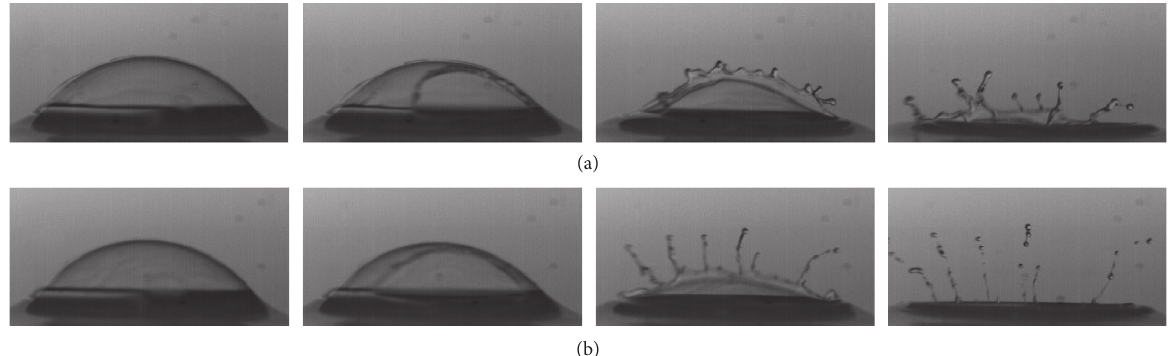
Figure 6: Visualization of bubble bursting with different lifetimes: (a) T � 0 . 32 s and (b) T � 5 . 76 s.